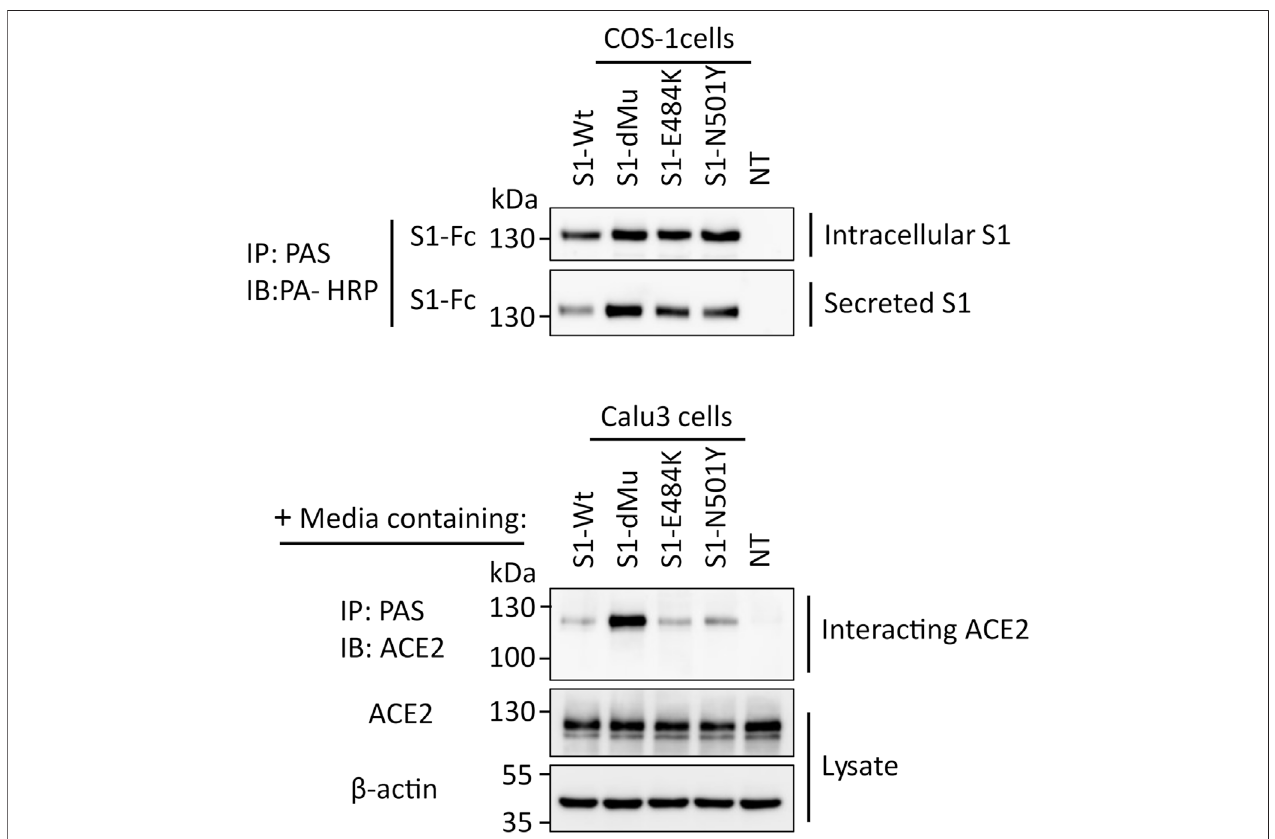
FIGURE 4 | S1-dMu mutant interacts avidly with the ACE2 receptor in Calu3 cells. After 48 h of transfection of COS-1 cells, S1 variants were analyzed for their expression and secretion, as explained before (upper two blots). Equal amounts of COS-1 media containing secretory S1 proteins were allowed to bind to the ACE2 receptor expressed in Calu3 cells for 2 h at 4 ° C. Following the time speci fi ed for interaction, Calu3 cells were washed twice with PBS, pH 7.4 and lysed, as described before. Cellular lysates were analyzed for ACE2 expression where actin was used as housekeeping control protein (lowest two blots). To assess the interacting ACE2, the remaining major part of Calu3 lysate was subjected to immunoprecipitation using pAb anti-ACE2 and blotted against ACE2. Notably, the S1-dMu mutant showed stronger interaction capability with ACE2 than the other S1 proteins as revealed in the upper blot of the Calu3 cells.